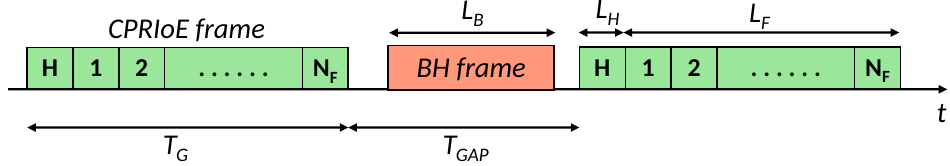
Figure 3. CPRI over Ethernet (CPRIoE) parameters applied to hybrid node. Table 1. List of parameters used to describe CPRI over Ethernet (CPRIoE) and hybrid